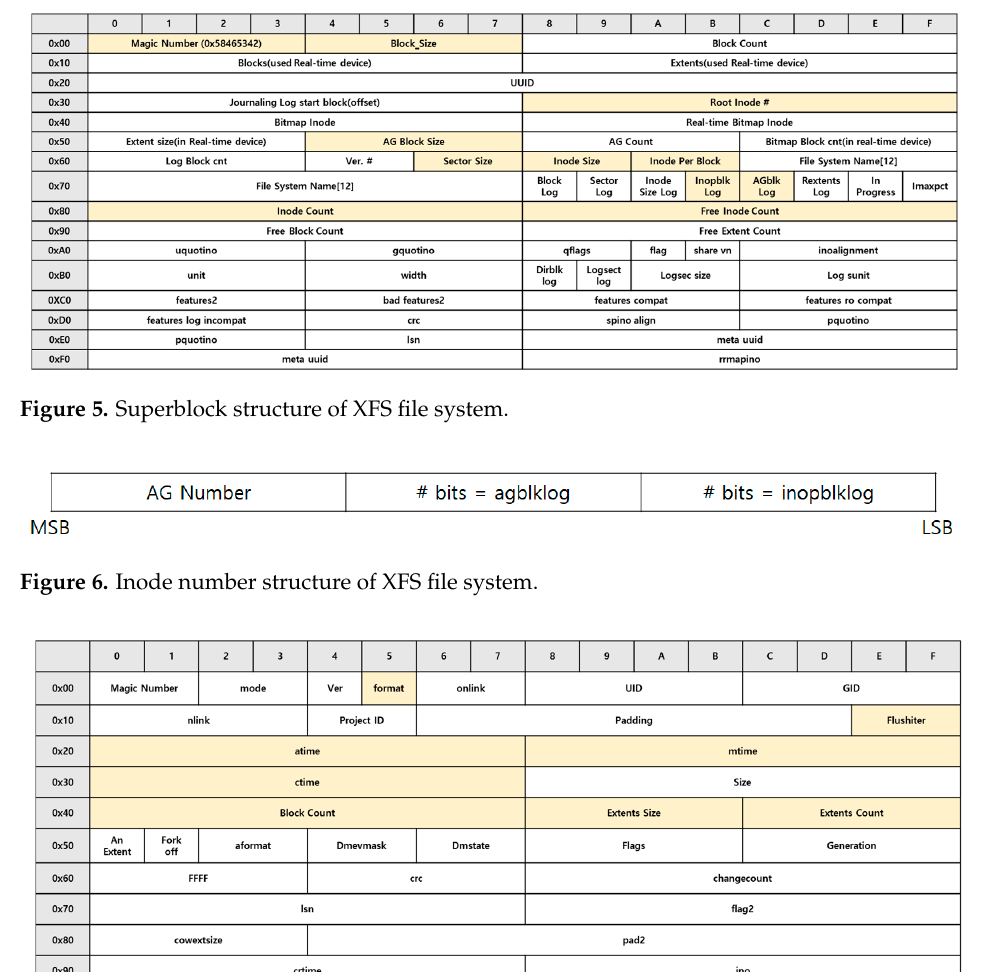
Figure 6. Figure 6. Inode number structure of XFS file system.